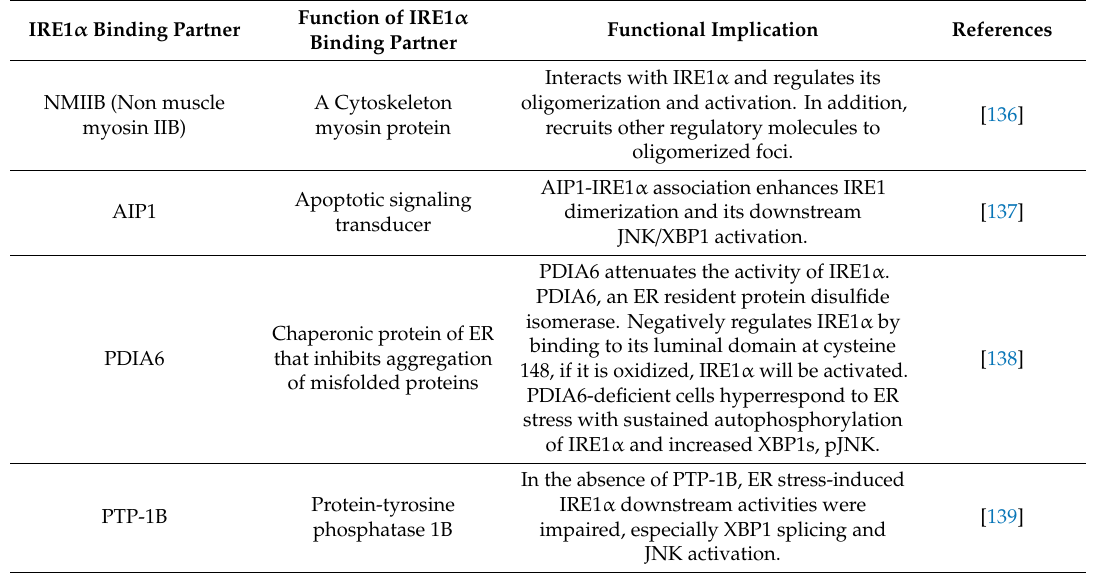
Table 2. Partners in regulating IRE α endoribonuclease